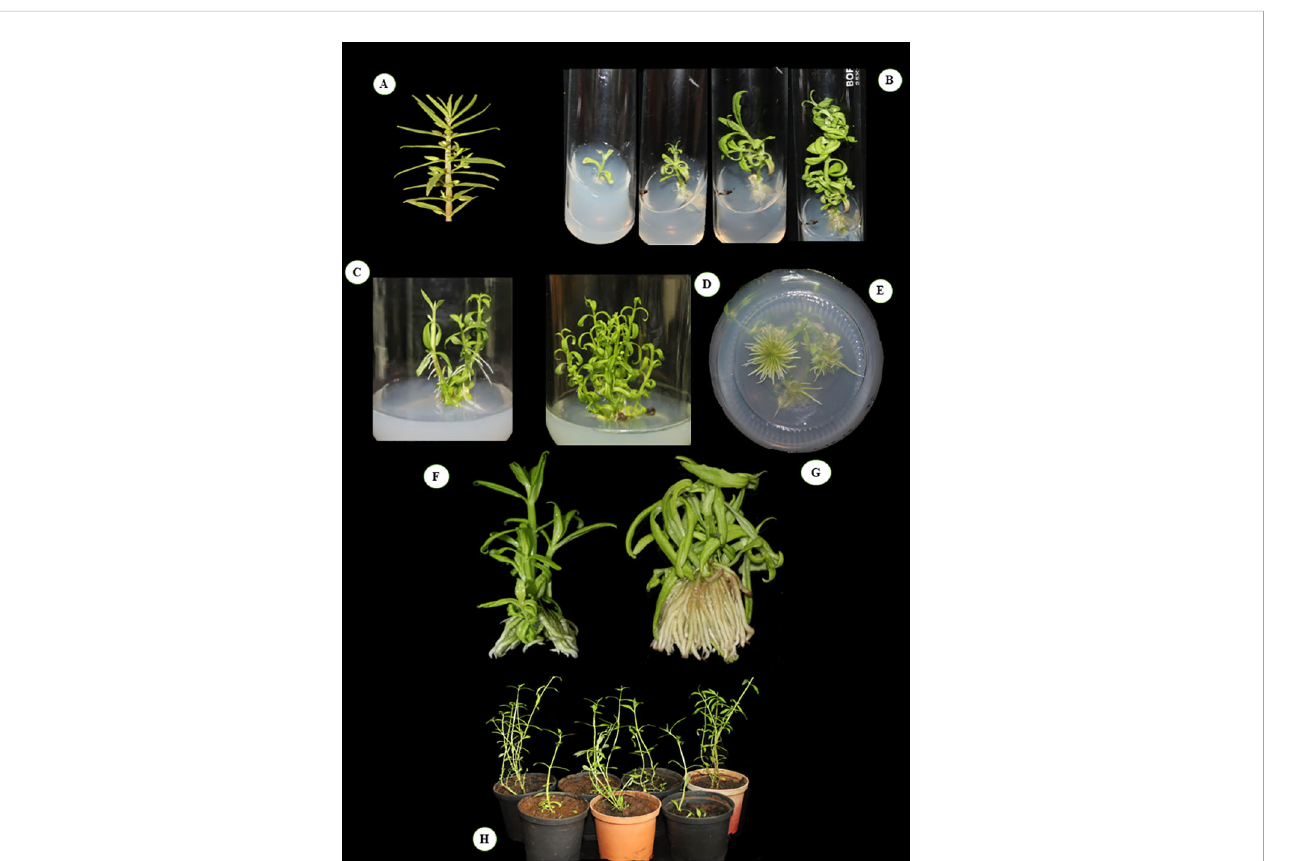
FIGURE 1 Different stages of micropropagation in Bacopa fl oribunda . (A) Mother plant; (B) various stages of caulogenesis. (C, D) Development of multiple shoots on cytokinin containing media. (E) Rooting of shoots. (F) Initiations of roots in optimum combination auxins. (G) Formation of multiple roots using optimum auxins. (H) Hardened plants (10 weeks